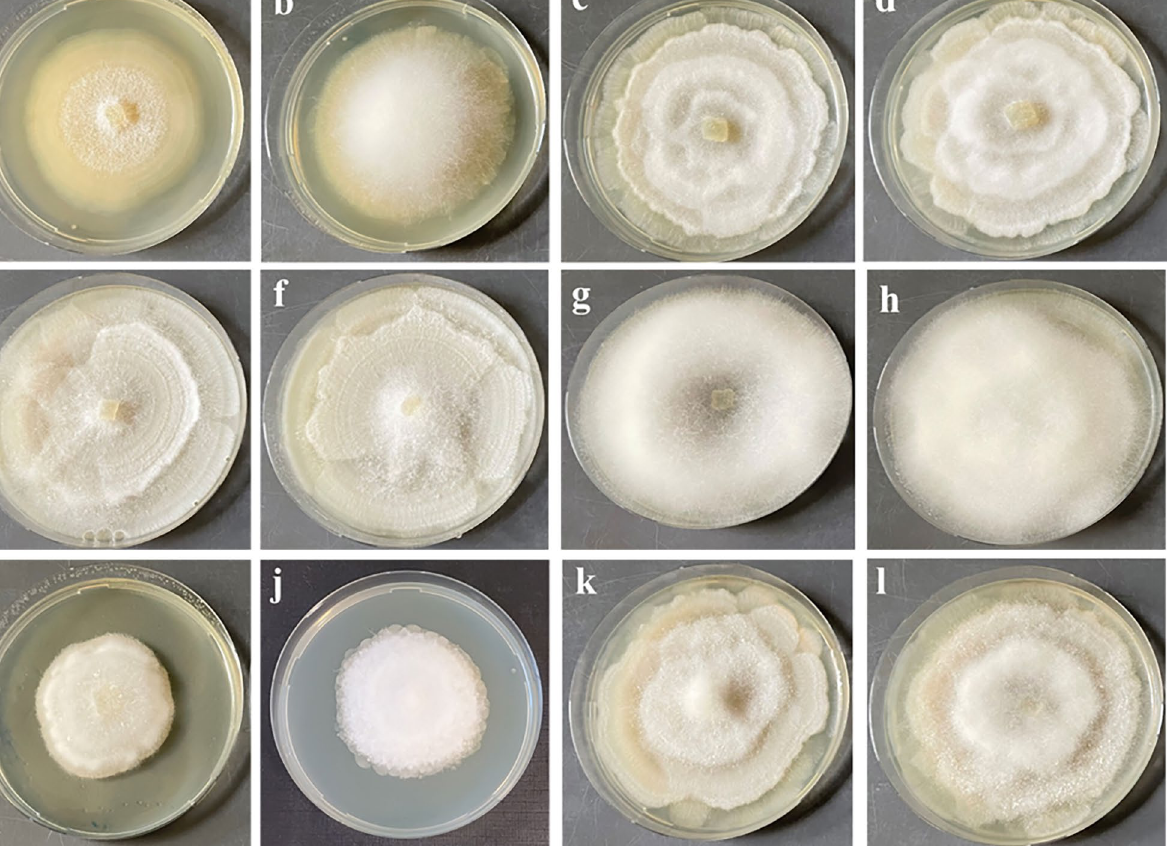
Figure 1. Morphology of Linnemannia and Entomortierella species on PDA in pure culture (second and forth column) and in co-culture with Pseudomonas helmanticensis (first and third column) incubated at 10 °C for ten days. One exemplary strain was randomly selected for each species. ( a , b ) E. galaxiae, ( c , d ) L. sclerotiella, ( e , f ) L. gamsii, ( g , h ) L. hyalina, ( i , j ) L. solitaria, ( k , l ) L. exigua . The formation of aerial mycelium is often reduced in co-cultivated strains, and the typical rosette-like colony morphology is less